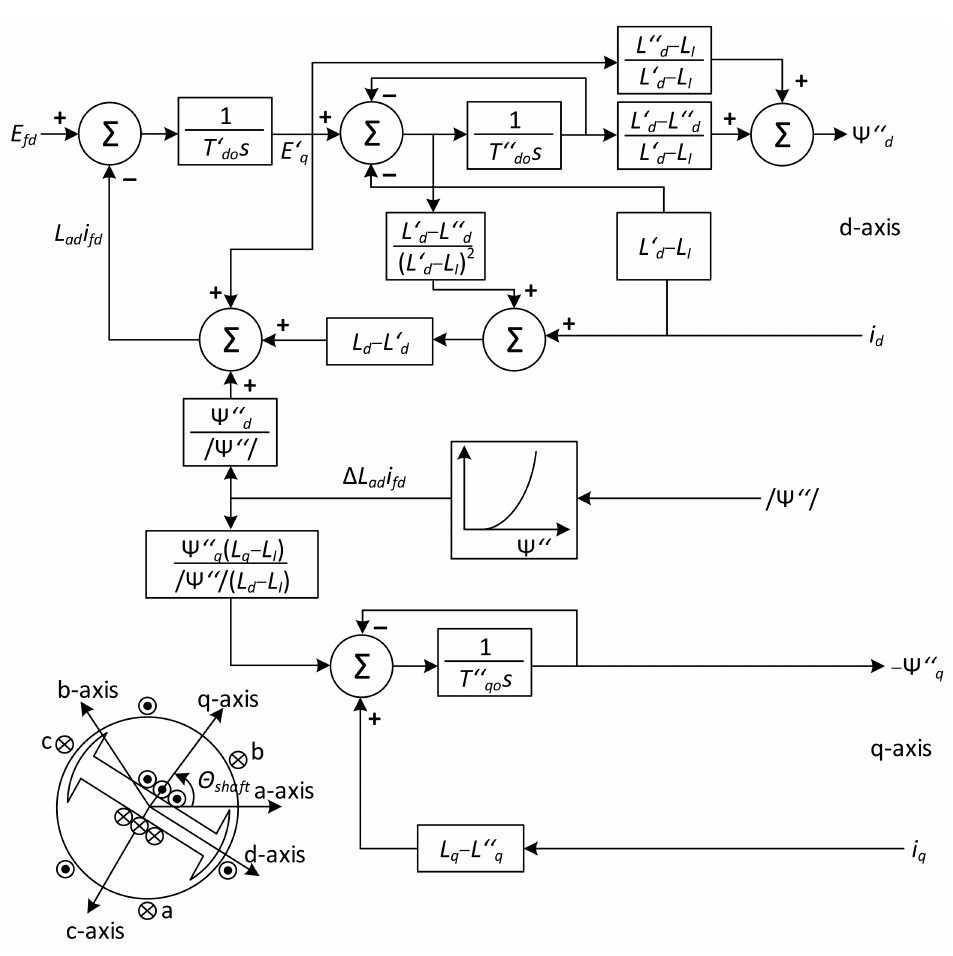
Figure 4. Structure of the electromagnetic model of a bright pole generator. In this model, the evaluation of rotor magnetic saturation occurs in the direct-axis d and in the quadrature-axis q . Saturation is described by a quadratic function. The model assumes that the magnetization acts on all of the generator’s existing mutual and leakage inductances. In modeling, the saturation value is considered to depend on both the rotor (excitation) and the stator currents [14]. Therefore, the effective values of the generator parameters in the model at each moment are converted